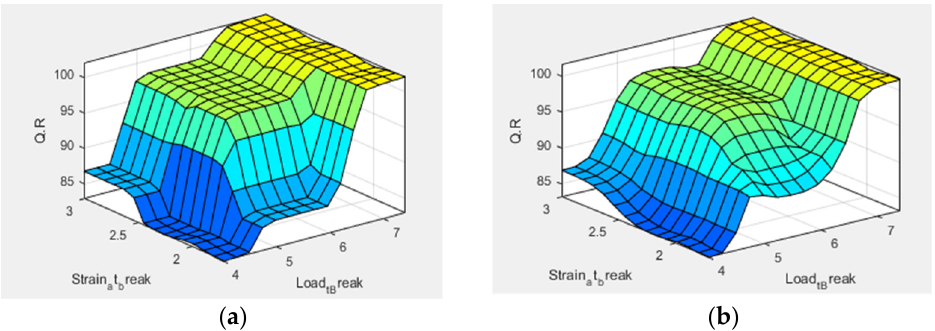
Figure 7. Surface view of load at break (X-axis) and strain at break (Y-axis) effect on jute yarn quality (Z-axis); ( a ) for triangular membership function and ( b ) gaussian membership function.